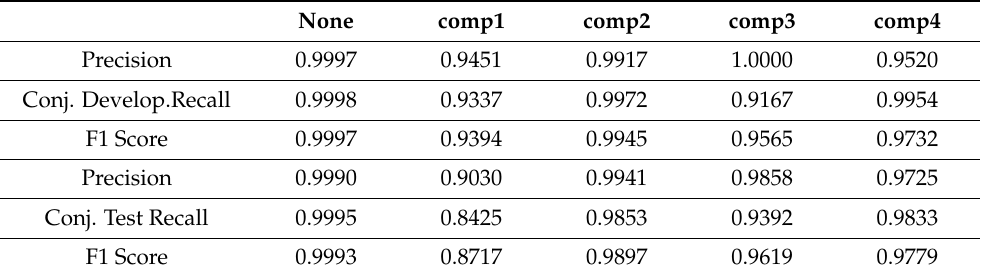
Table 15. Performance for the Artificial Neural Network model in the validation and test sets, with 100 hidden layers (hidden layers = 100) and min-max scaling